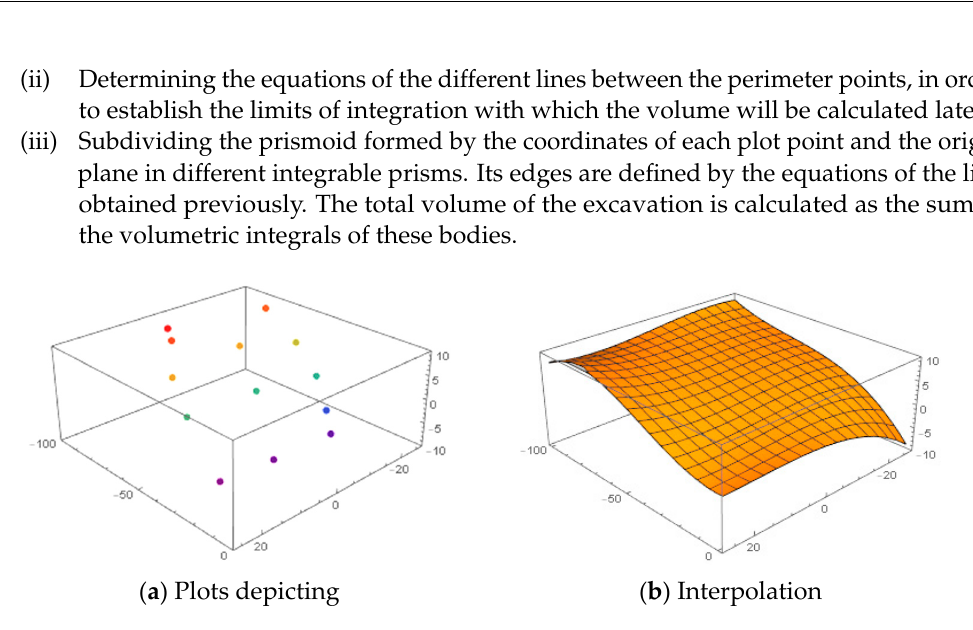
Figure 2. ( a ) Representation of the plot’s relief, with a 13-point cloud in cartesian coordinates. ( b ) Its numerical approximation with an interpolating polynomial obtained with the least squares method.